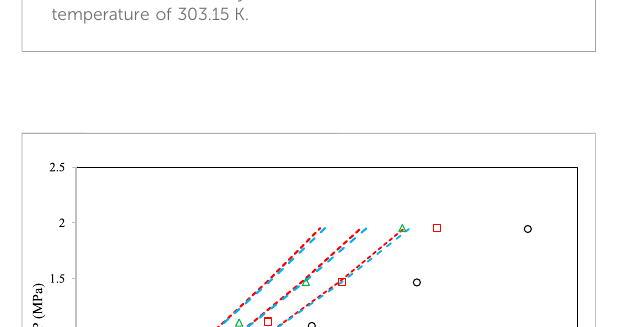
FIGURE 9 Comparison of the phase behavior of CO 2 with 1-tetrabutyl ammonium bromide (TBAB) + n-diethylene glycol (Haider et al., 2018) (n = 2, 3, and 4) by the correlative mode of PC-SAFT, at the temperature of 303.15 K.